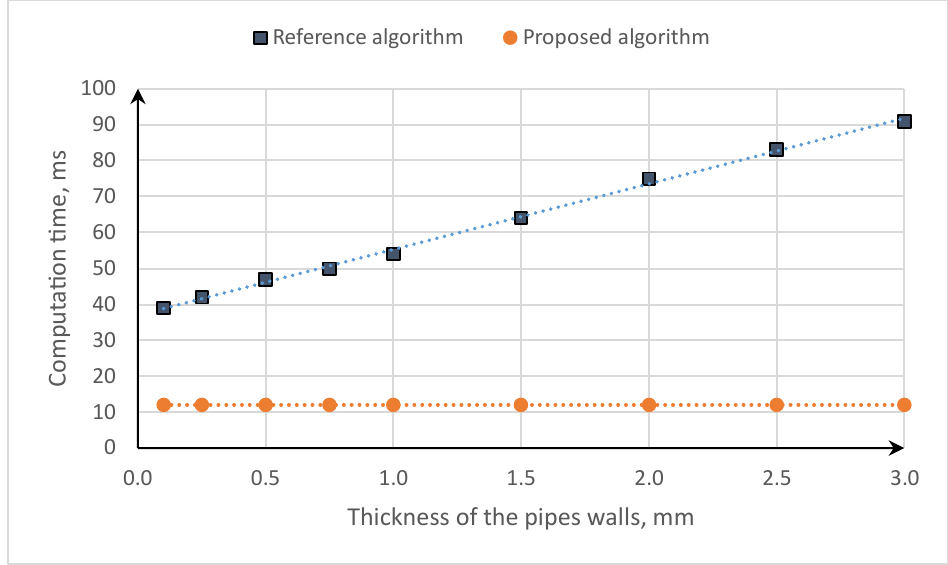
Figure 5. Comparison of the computation time of the characteristic impedance for the algorithm [30] and newly developed equations.